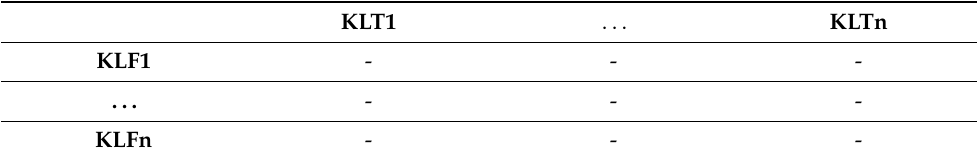
Table 8. Cross-arrangement of classes of the similarity of attributes: project profitability/campaign